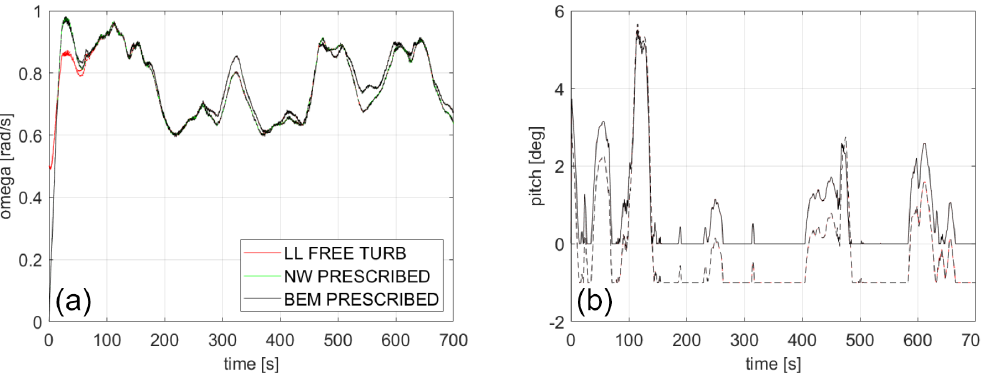
Figure 13. (a) Rotational speed and (b) pitch signal of the baseline and optimized design. Solid lines represent the baseline blade, while dashed lines represent the optimized tip